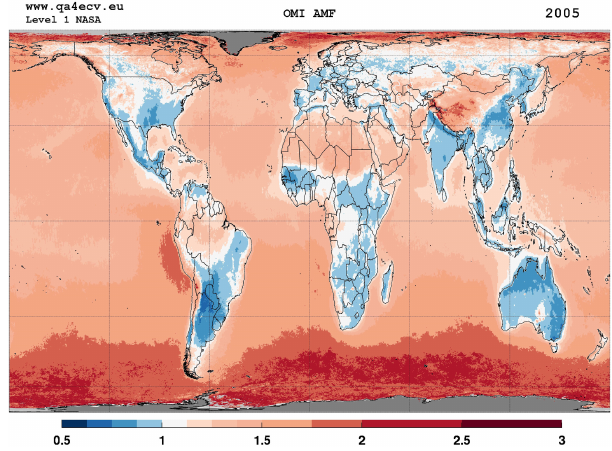
Figure 7. Yearly averaged map of tropospheric air mass factors at 340nm using the QA4ECV OMI HCHO algorithm. A priori HCHO profiles from high-resolution TM5-MP model runs have been used. The IPA cloud correction is applied for effective cloud fractions f eff larger than 10%. Observations with f eff larger than 30% have been filtered